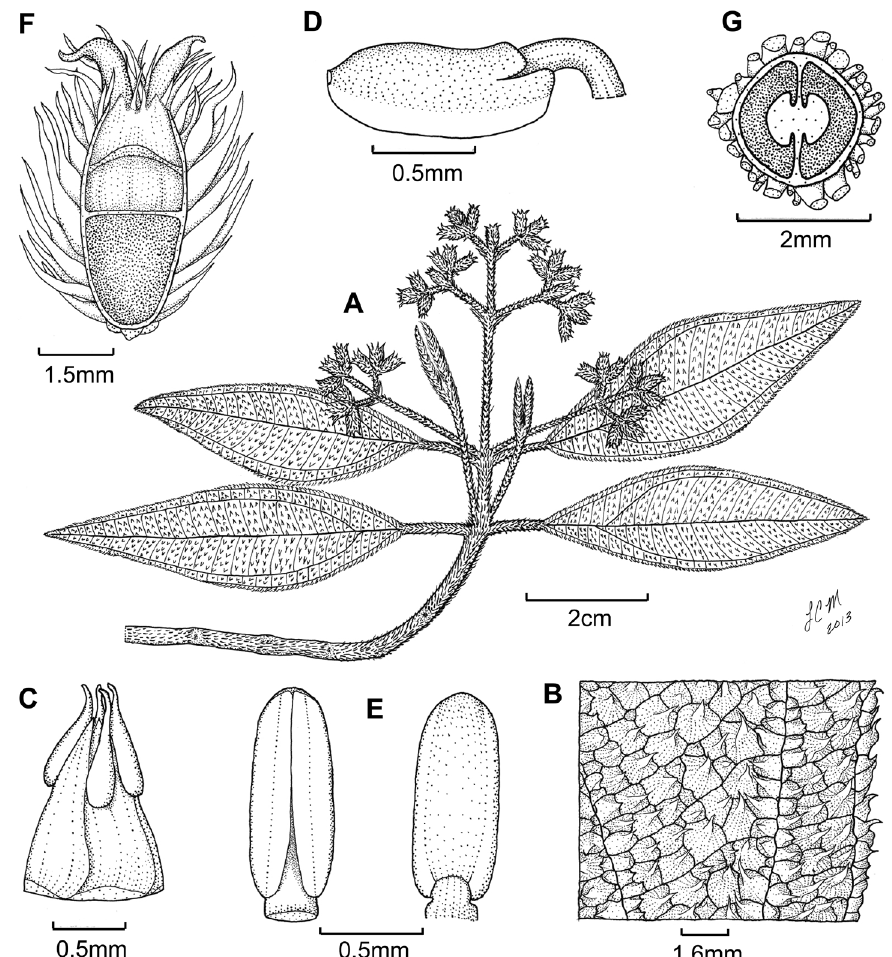
Figure 25. Illustration of Miconia marigotiana A habit B adaxial leaf surface showing well developed bulla-based hairs completely covering areoles C petals in bud showing bulla-based hairs on abaxial surface D stamen E anther ventral and dorsal surfaces F immature fruit longitudinal section G fruit cross section showing two carpels (all from Ekman 10071 )